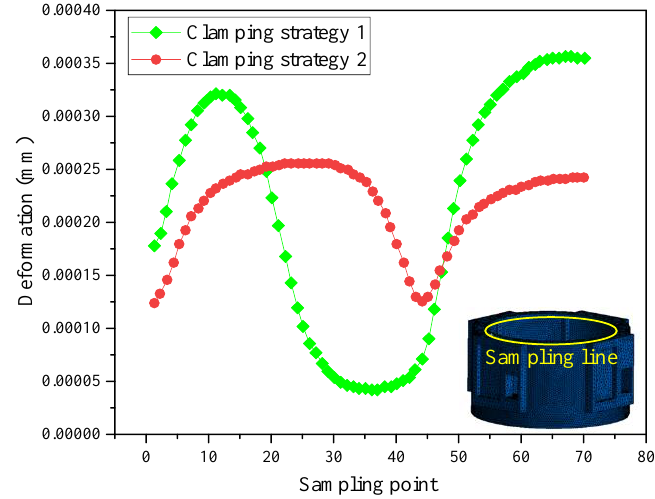
Figure 6. Deformation of inner circumference sampling line.